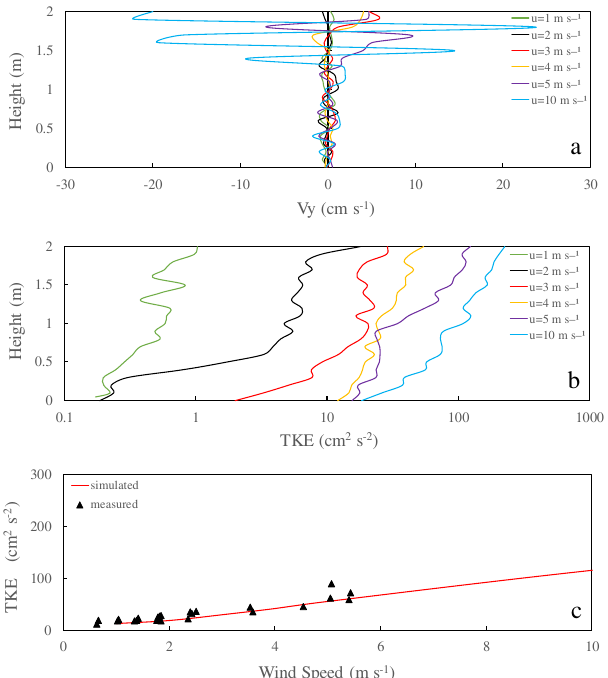
Figure 2. Simulated structure of wind-driven currents ( a ), relationship between depth and TKE ( b ), relationship between TKE and wind speed ( c ).